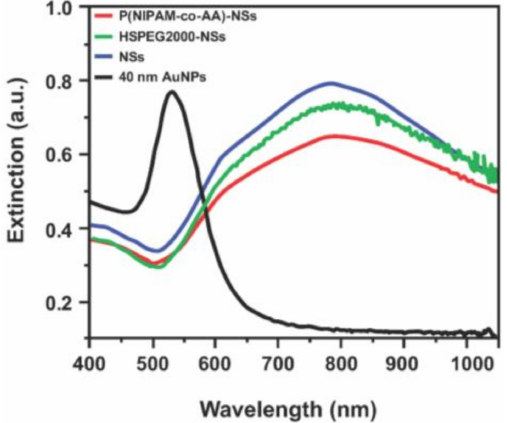
Figure 5. UV-Vis spectra of the 40-nm AuNPs (black), bare nanoshells (blue), HSPEG2000 -modified nanoshells (green) and the hydrogel-coated nanoshells